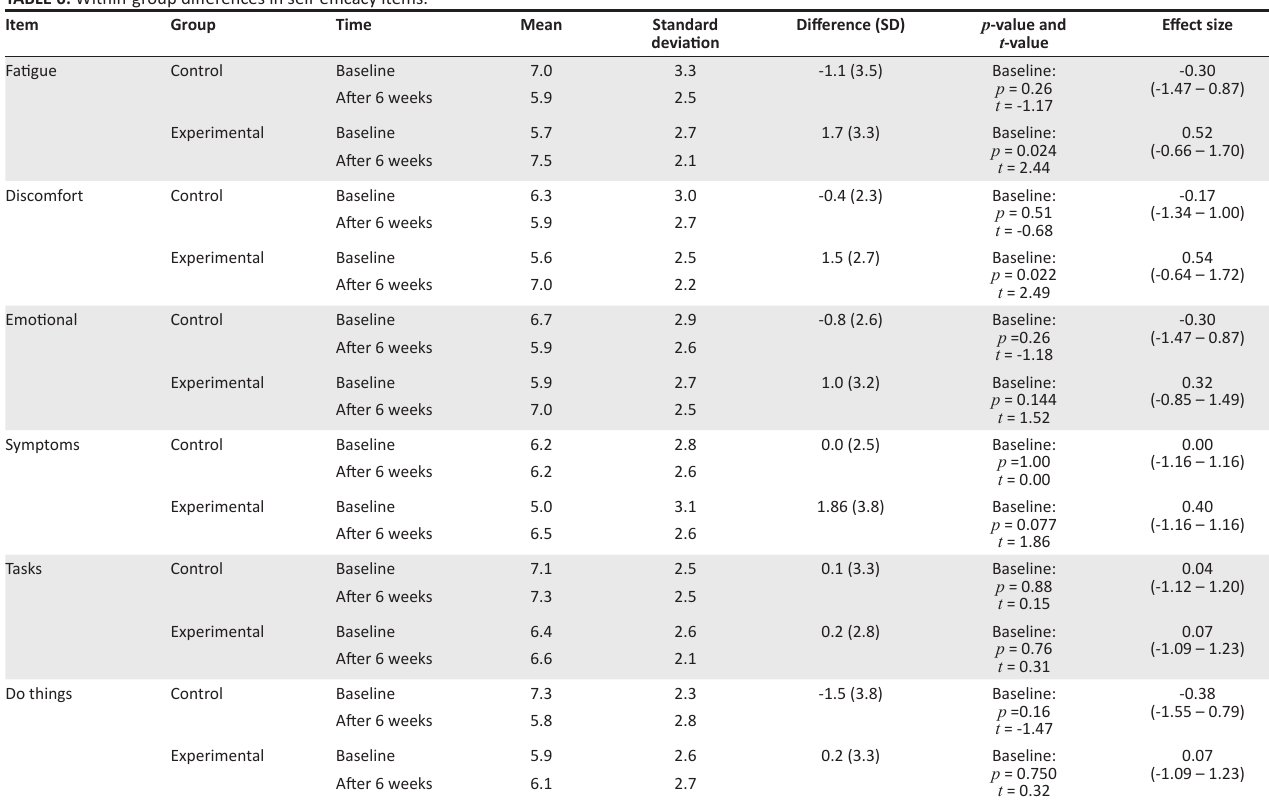
TABLE 6: Within-group differences in self-efficacy